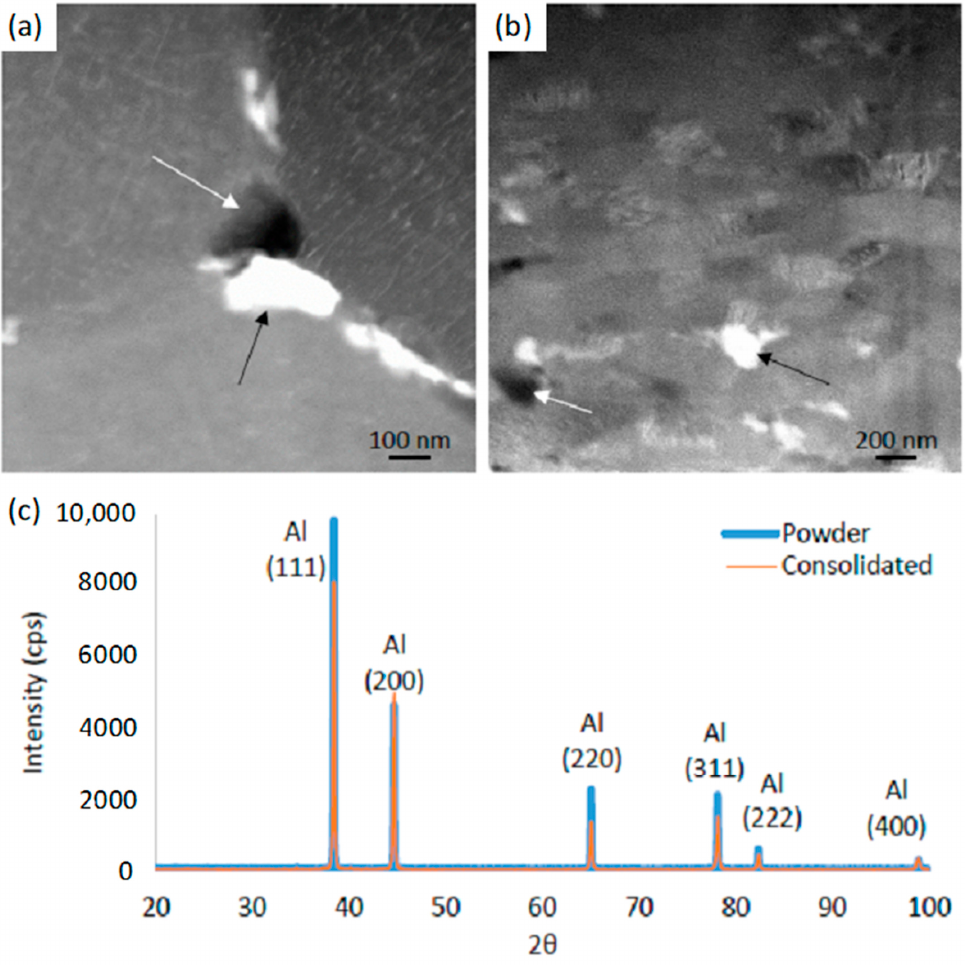
Figure 2. STEM images of ( a ) Al 6061 powder with a scale bar of 100 nm and ( b ) Al 6061 cold spray with a scale bar of 200 nm. The white arrows indicate the dark phase in both images, and the black arrow indicates the white phase. ( c ) presents XRD pattern for Al 6061 powder and consolidated material. As already mentioned, Al 6061 has been highly regarded and considered within the CSAM community since the 2000s and remains as such [40]. Still, consideration of the current state of the literature surrounding the use of rapidly solidified and gas-atomized Al 6061 particulate feedstock within CSAM processing unveils an ongoing discrepancy surrounding the microstructural solidification type or class such rapidly solidified alloyed aluminum microparticulate powders belong. Stated otherwise, researchers have claimed that gas-atomized metallic droplets’ rapidly solidified, non-equilibrium, and undercooled nature may vary between dendritic, mixed dendritic/cellular (also known as compound),